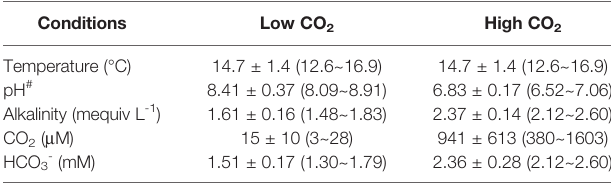
TABLE 1 | Conditions in the low and high CO 2